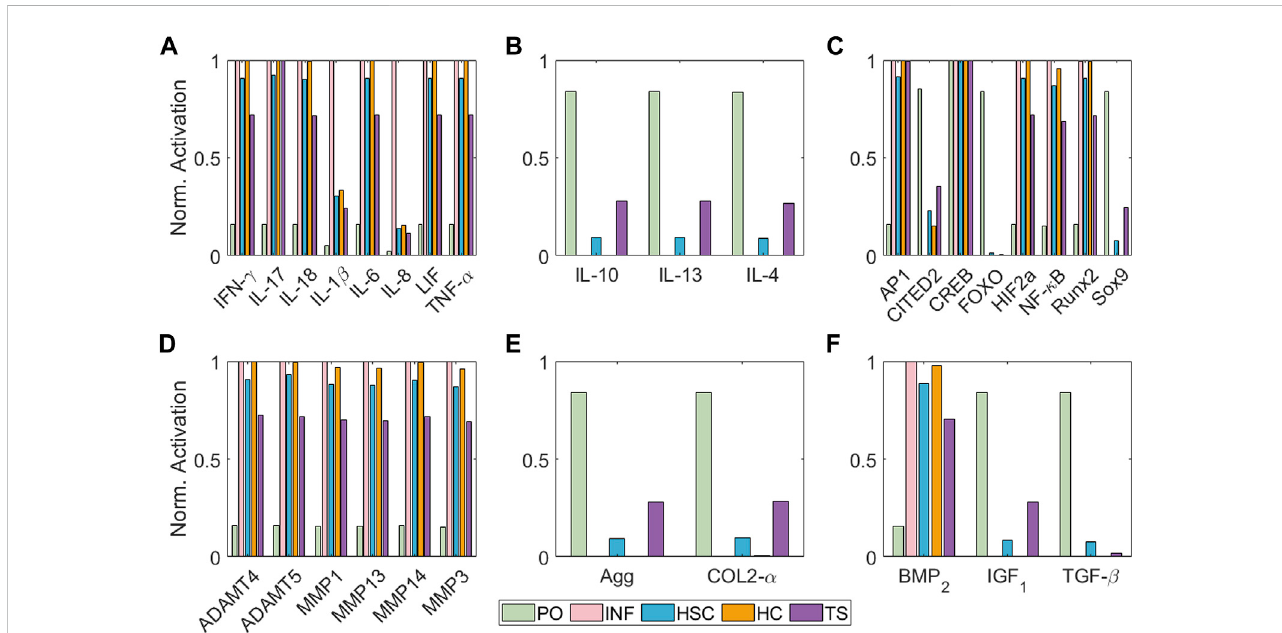
FIGURE 5 Steady States of the model regarding different initial conditions in terms of node activation levels of: (A) pro-in fl ammatory mediators, (B) anti- in fl ammatory cytokines, (C) transcription factors, (D) degrading enzymes, (E) structural proteins and (F) growth factors. Bar colours represent the initial condition applied: Physio-osmotic (PO) in green, in fl ammatory (INF) in pink, static compression (HSC) in blue, high compression (HC) in orange and tensile strain (TS) in